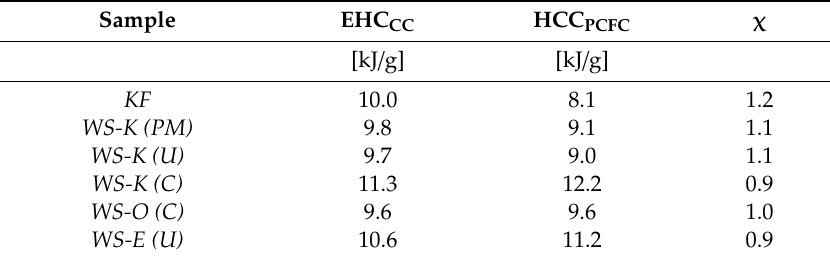
Table 7. Determination of combustion e ffi ciency χ from CC and PCFC